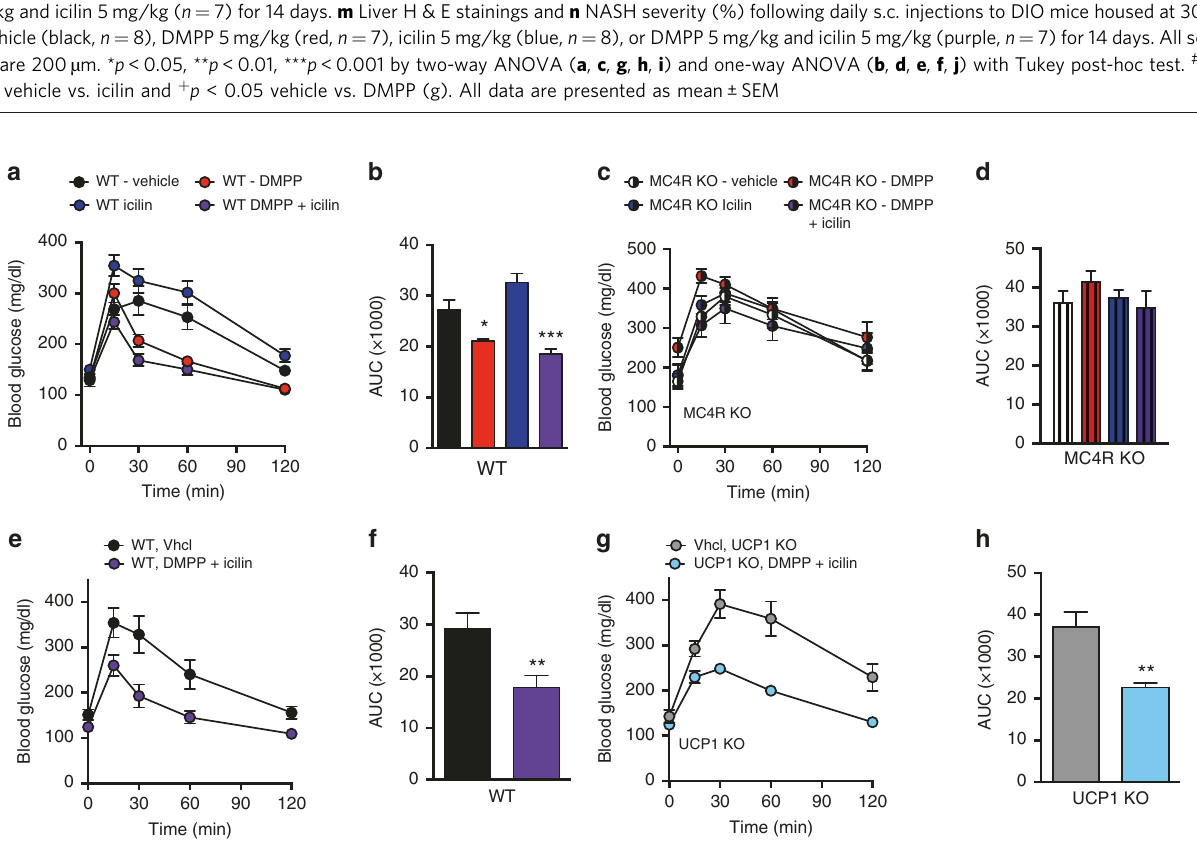
Fig. 6 Icilin and DMPP reverse diet-induced glucose intolerance, insulin resistance, and hepatic steatosis in DIO mice. a , b Effects on glucose tolerance and c , d glucose-stimulated insulin secretion following daily s.c. injections to DIO mice of vehicle (black, n = 8), DMPP 10 mg/kg (red, n = 8), icilin 5 mg/kg (blue, n = 8), or DMPP 10 mg/kg and icilin 5 mg/kg (purple, n = 7) for 7 days. e Effects on 6-h fasted insulin levels, f HOMA-IR score, and g insulin tolerance following daily s.c. injections to DIO mice of vehicle (black, n = 8), DMPP 10 mg/kg (red, n = 8), icilin 5 mg/kg (blue, n = 8), or DMPP 10 mg/kg and icilin 5 mg/kg (purple, n = 7) for 7 days at 23 °C. h Effect on insulin tolerance following 14 days of daily s.c. injections of vehicle (black, n = 8), DMPP 5 mg/kg (red, n = 7), icilin 5 mg/kg (blue, n = 8), or the combination of DMPP 5 mg/kg and icilin 5 mg/kg (purple, n = 7) in DIO mice housed at 30 °C. i and j Effect on pyruvate tolerance following daily s.c. injections to DIO mice of vehicle (black, n = 7), DMPP 5 mg/kg (red, n = 7), icilin 5 mg/kg (blue, n = 7), or DMPP 5 mg/kg and icilin 5 mg/kg (purple, n = 7) for 20 days. k Plasma lipoprotein fractions following daily s.c. injections to DIO mice of vehicle (black, n = 7), DMPP 5 mg/kg (red, n = 7), icilin 5 mg/kg (blue, n = 7), or DMPP 5 mg/kg and icilin 5 mg/kg (purple, n = 7) for 21 days. l Effect on hepatic steatosis score following daily s.c. injections to DIO mice housed at 23 °C of vehicle ( n = 8), DMPP 10 mg/kg ( n = 8), icilin 5 mg/kg ( n = 8), or DMPP